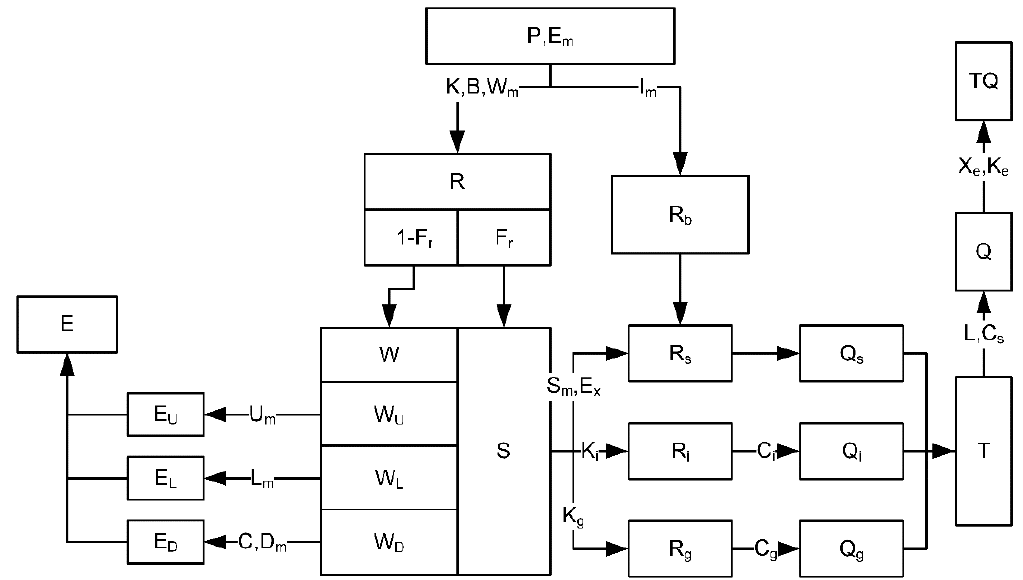
Figure 2. Flow chart and parameters of the XAJ model.